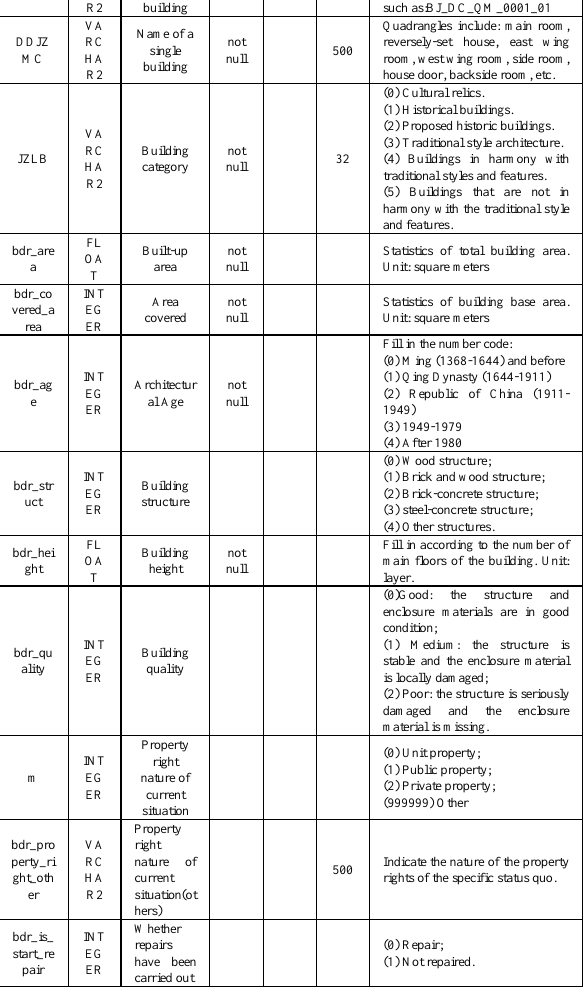
Table 7 Element class attribute structure